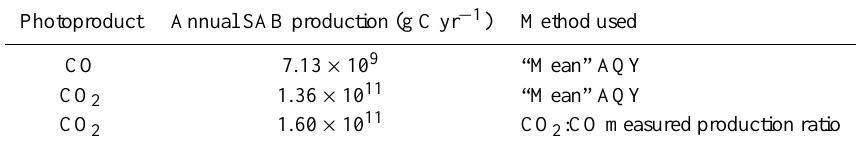
Table 3. Annual photoproduction calculated for the estuaries and inner shelf of the South Atlantic Bight (SABi) for CO and CO 2 . Photoproduct